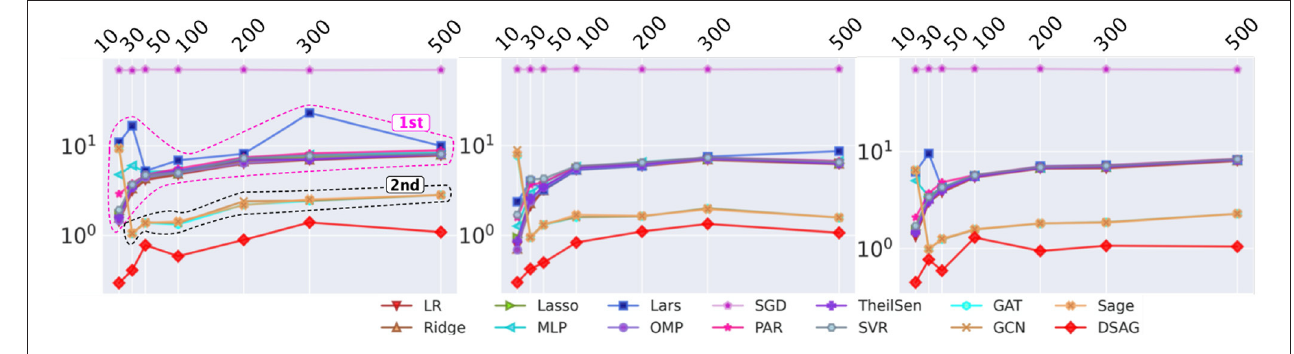
FIGURE 3 | Comparison with